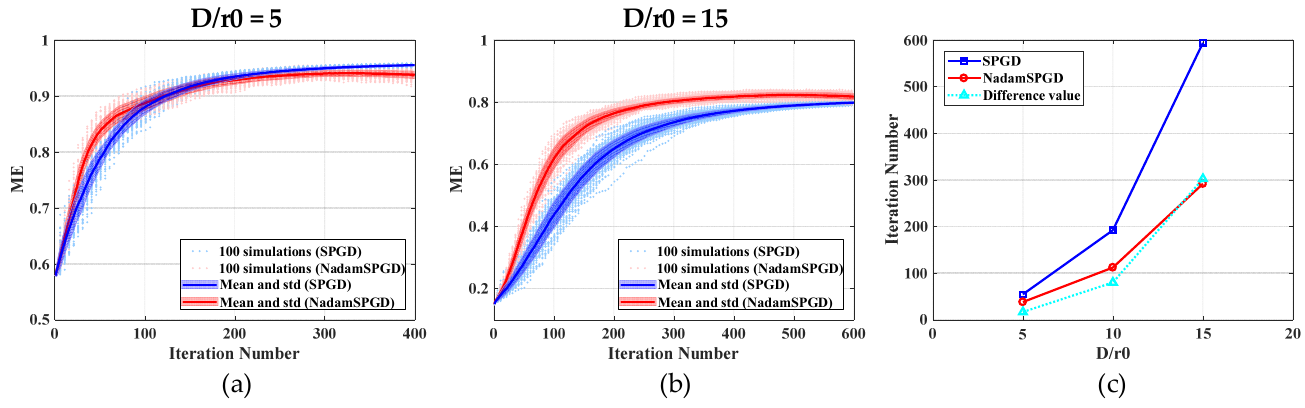
Figure 7. Comparison of SPGD and NadamSPGD under different turbulence intensities: ( a ) correc- tion curves using SPGD and NadamSPGD when D / r 0 = 5; ( b ) correction curves using SPGD and NadamSPGD when D / r 0 = 15; ( c ) number of iterations required for ME reaching to 0.8 of the two algorithms and the difference between them under different D / r 0 .